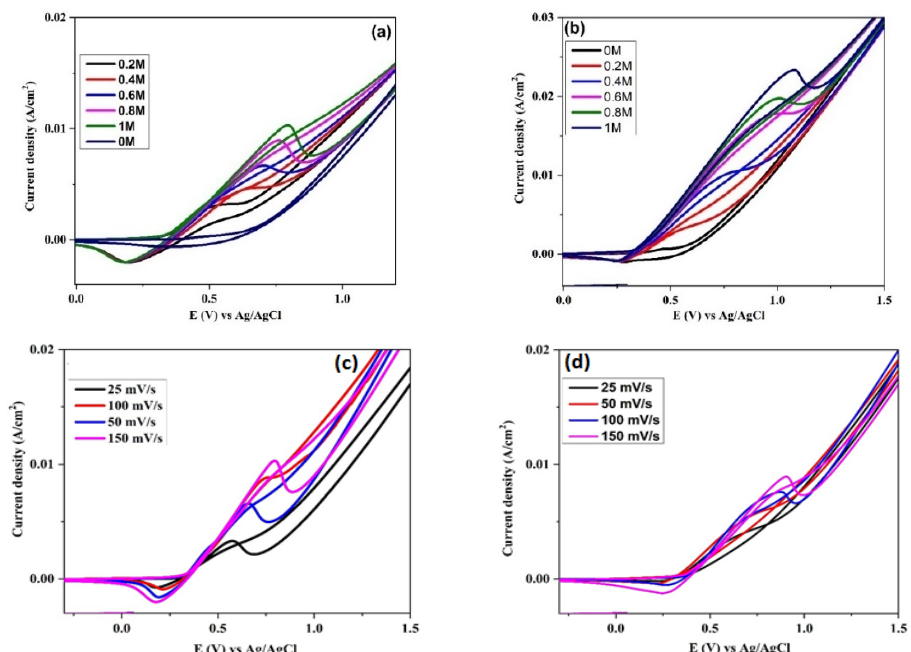
Figure 4. Cyclic voltammogram of ( a ) NiO-Y 2 O 3 /FTO and ( b ) NiO-ZrO 2 /FTO thin films in 0.5 M NaOH solution using 0, 0.2, 0.4, 0.6, 0.8 and 1 M methanol solution at scan rate of 100 mV/s. ( c ) cyclic voltammogram of NiO-Y 2 O 3 /FTO and ( d ) NiO-ZrO 2 /FTO thin films using 0.6 M methanol solution at scan rates of 25, 50, 100, and 150 mV/s. Table 2. Current densities of NiO-Y 2 O 3 /FTO thin film for different concentrations of methanol at specified potentials.